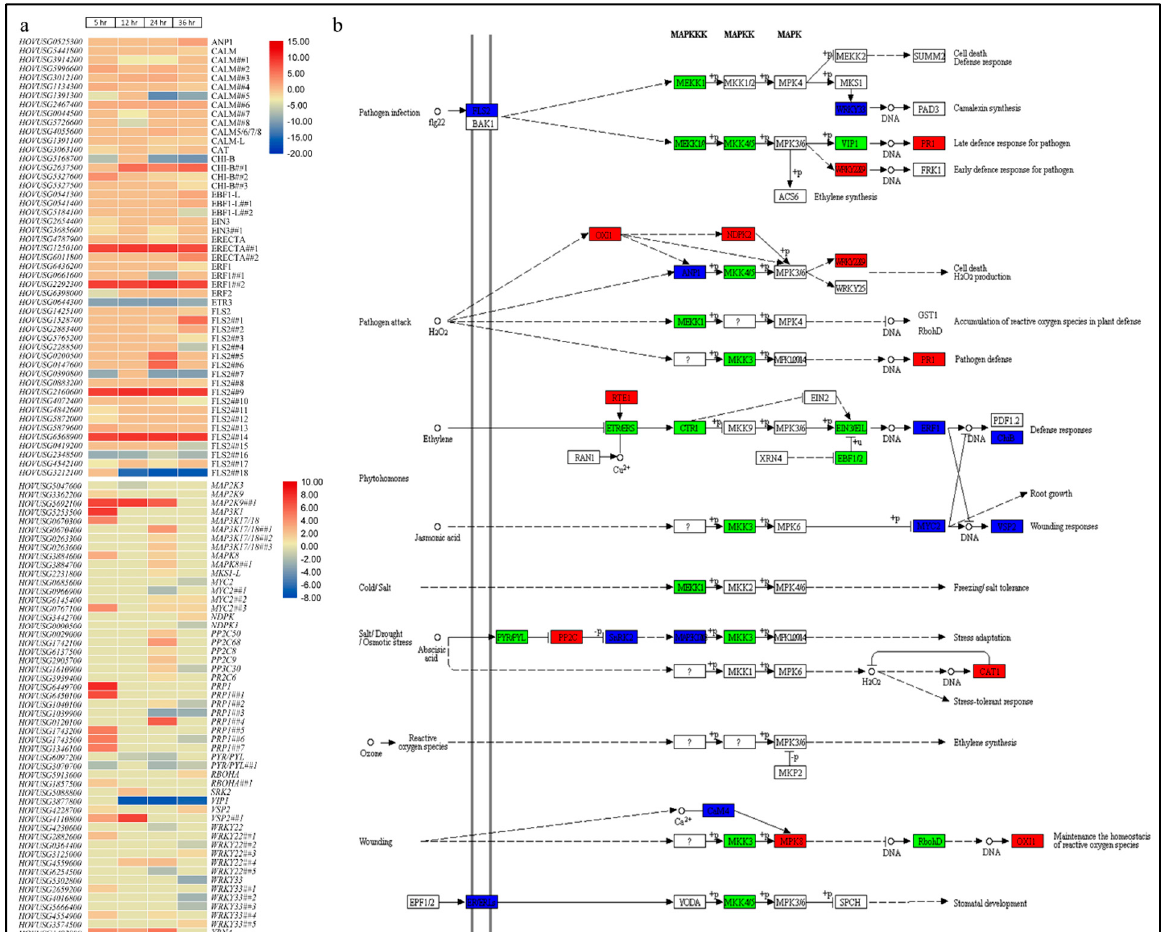
Figure 5. Regulation of MAPK signaling pathway in hulless barley in response to PM infection after 5, 12, 24, and 36 hpi. ( a ) Heatmaps showing log2 FC values of DEGs at different time points (XL19/ZYM1288). ( b ) Pathway map showing the differential regulation of MAPK signaling pathway between XL19 and ZYM1288 after 5 hpi. The genes highlighted in green, red, and blue colors represent down-, up-, and up/down-regulated DEGs.